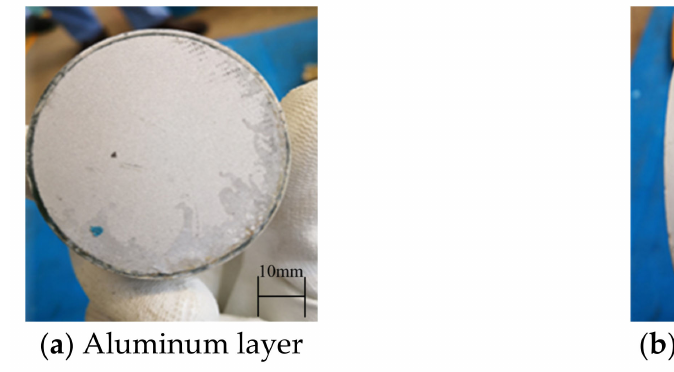
Figure 5. Typical appearance of a defective arrester varistor.